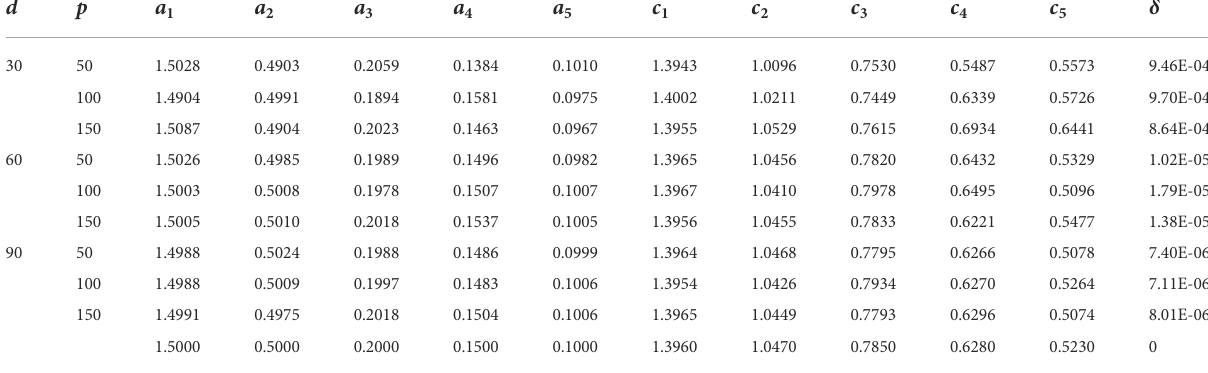
TABLE 1 Results of parameter estimates of Example 1 for G = 500.